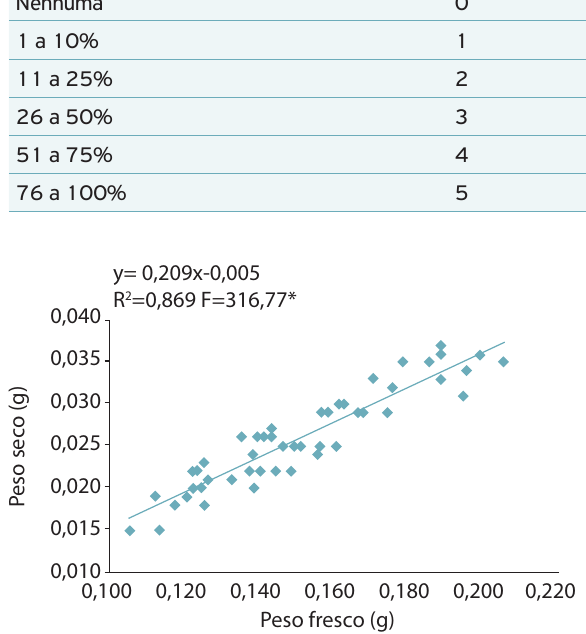
Figura 1. Curva de regressão obtida para as alíquotas de pesos fresco e seco de discos de discos de folhas de couve.